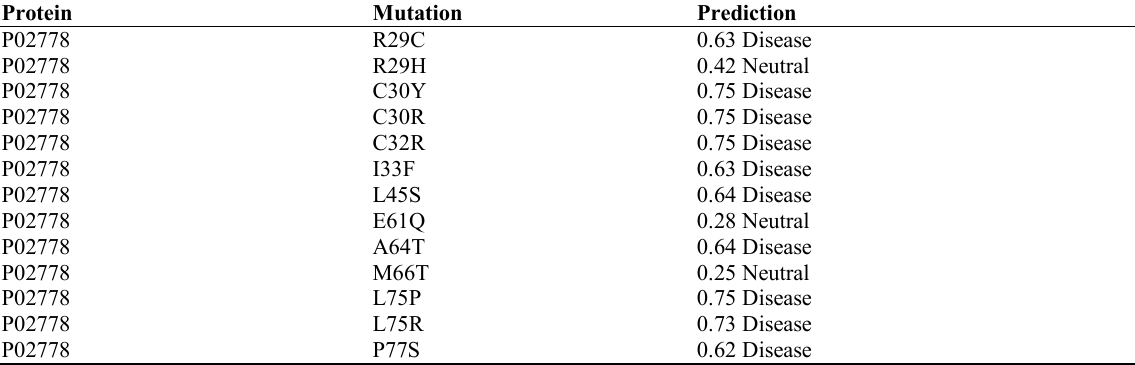
Table 2. Results of the PMUT server for the most deleterious nsSNPs. Amino acid substitutions with a prediction score of 0 to 0.5 are grouped as neutral, while pathological ones score from 0.5 to